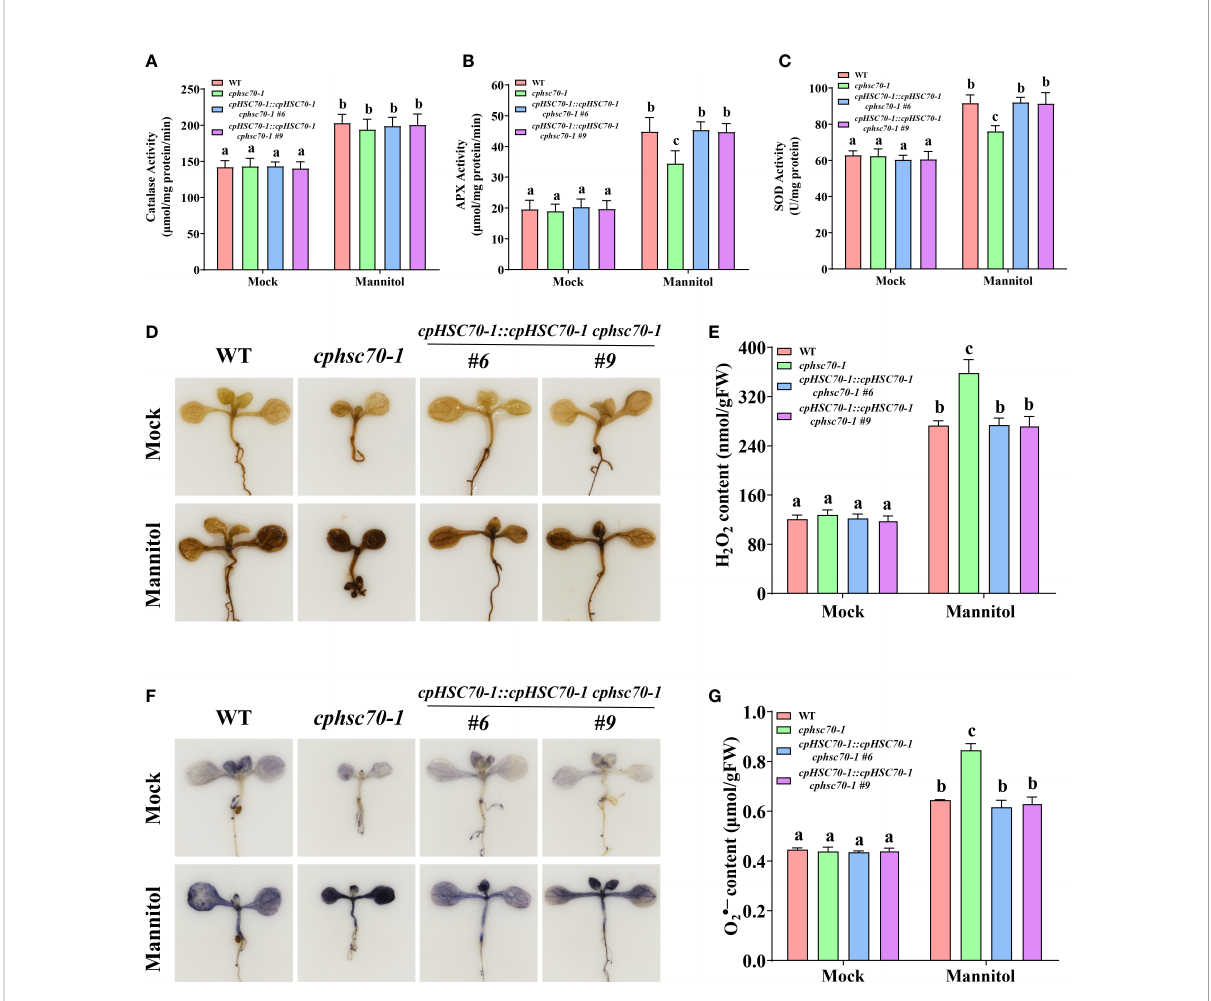
FIGURE 5 The cphsc70-1 mutant has higher ROS accumulation and reduced APX and SOD activity. (A) Catalase activity, (B) APX activity, and (C) SOD activity of the 5-day-old wild-type, cphsc70-1 , and cpHSC70-1::cpHSC70-1 cphsc70-1 plants treated with or without (Mock) 300 mM mannitol for 2 days. (D) The DAB-staining images of leaves from the 5-day-old wild-type, cphsc70-1 , and cpHSC70-1::cpHSC70-1 cphsc70-1 plants treated with or without (Mock) 300 mM mannitol for 2 days. (E) Measurements of H 2 O 2 in the 5-day-old wild-type, cphsc70-1 , and cpHSC70-1:: cpHSC70-1 cphsc70-1 plants treated with or without (Mock) 300 mM mannitol for 2 days. (F) The NBT-staining images of leaves from the 5- day-old wild-type, cphsc70-1 , and cpHSC70-1::cpHSC70-1 cphsc70-1 plants treated with or without (Mock) 300 mM mannitol for 2 days. (G) Measurements of O (cid:129) − 2 in the 5-day-old wild-type,